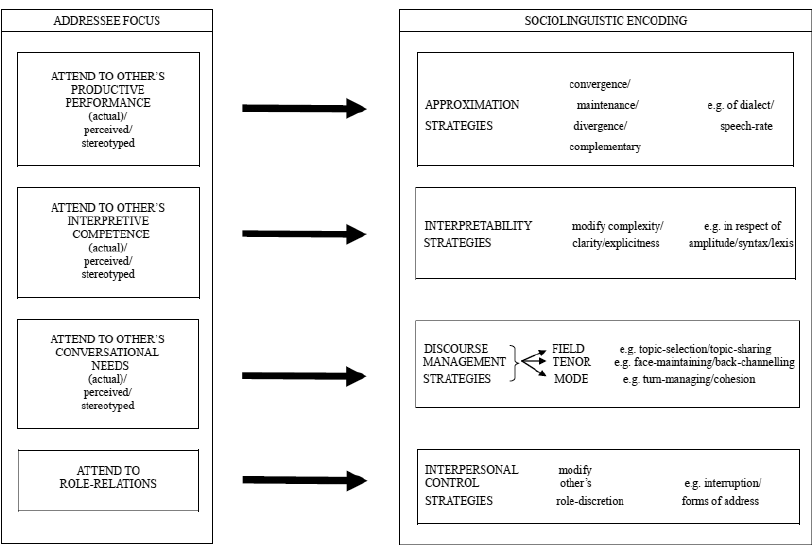
Figure 1. An extended model of sociolinguistic processes in communication accommodation